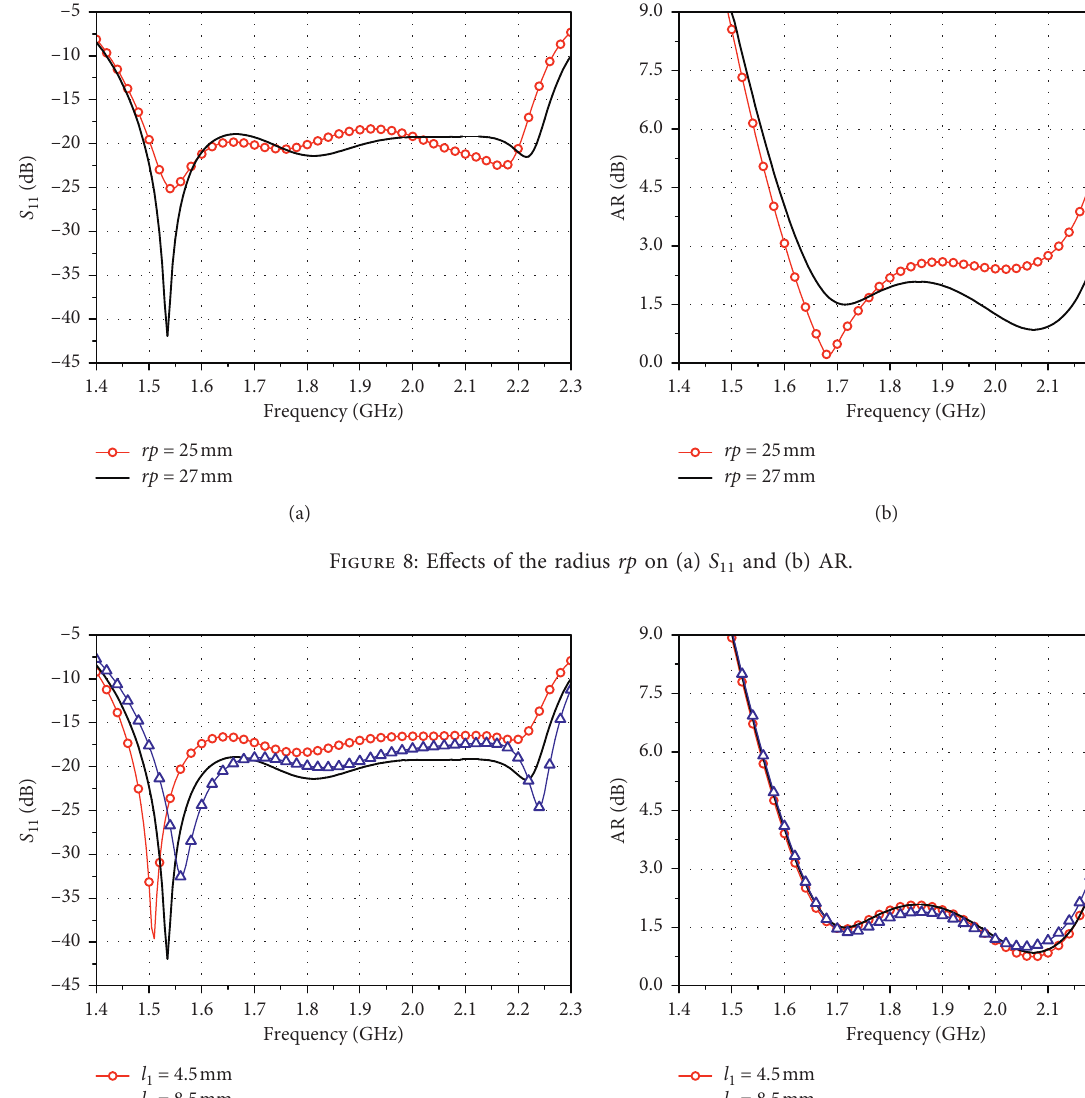
Figure 9: Effects of the length l